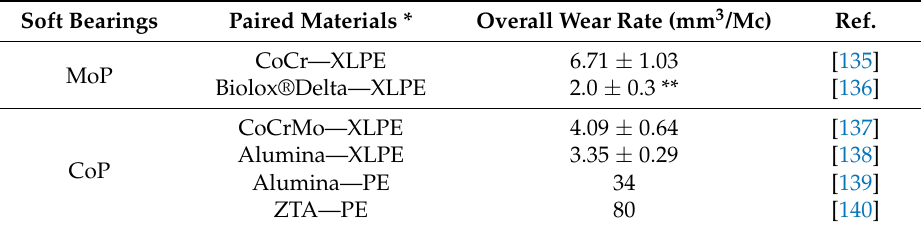
Table 1. Soft bearings’ wear rates found in vitro through